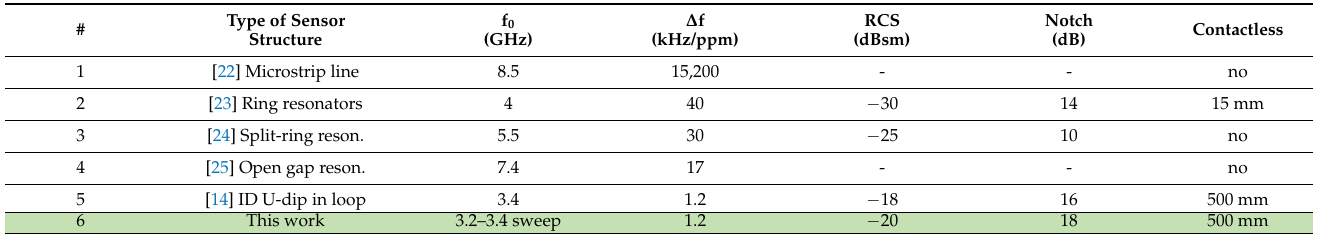
Table 6. Comparison of properties of microwave acetone